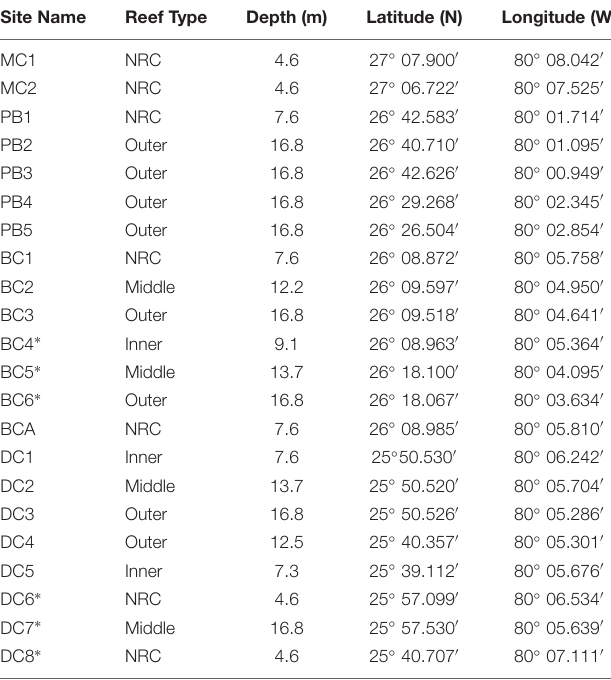
TABLE 1 | SECREMP monitoring site characteristics and locations.